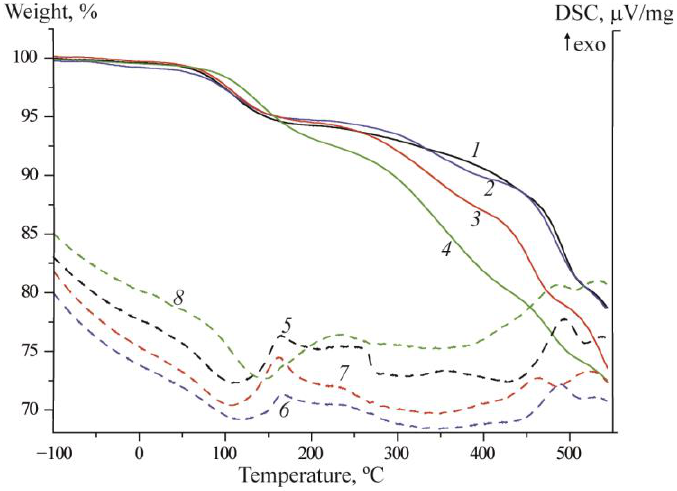
Figure 5. Thermal stability of initial PBI (1, 5), PBI/SiBr (2, 6), PBI/SibiC (3, 7) and PBI/KH 560 (4, 8) membranes with a crosslinking degree of 0.3.